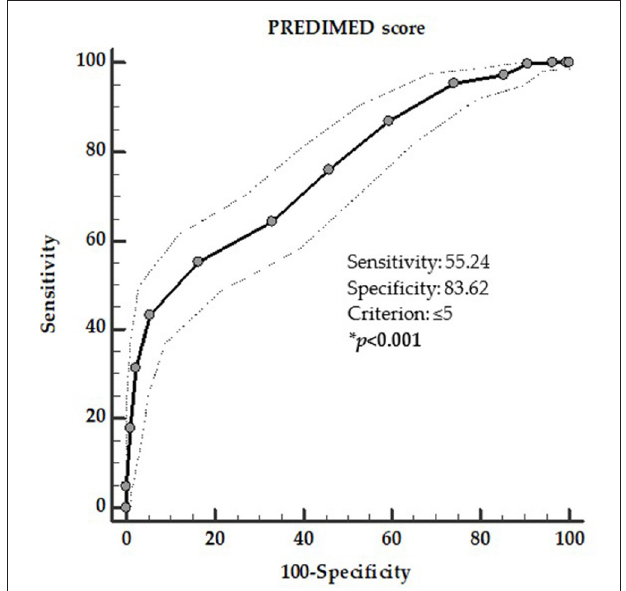
FIGURE 2 | ROC for predictive values of PREDIMED score in detecting the presence of thyroid nodules. A PREDIMED score ≤ 5 ( p = 0.001, AUC 0.758,